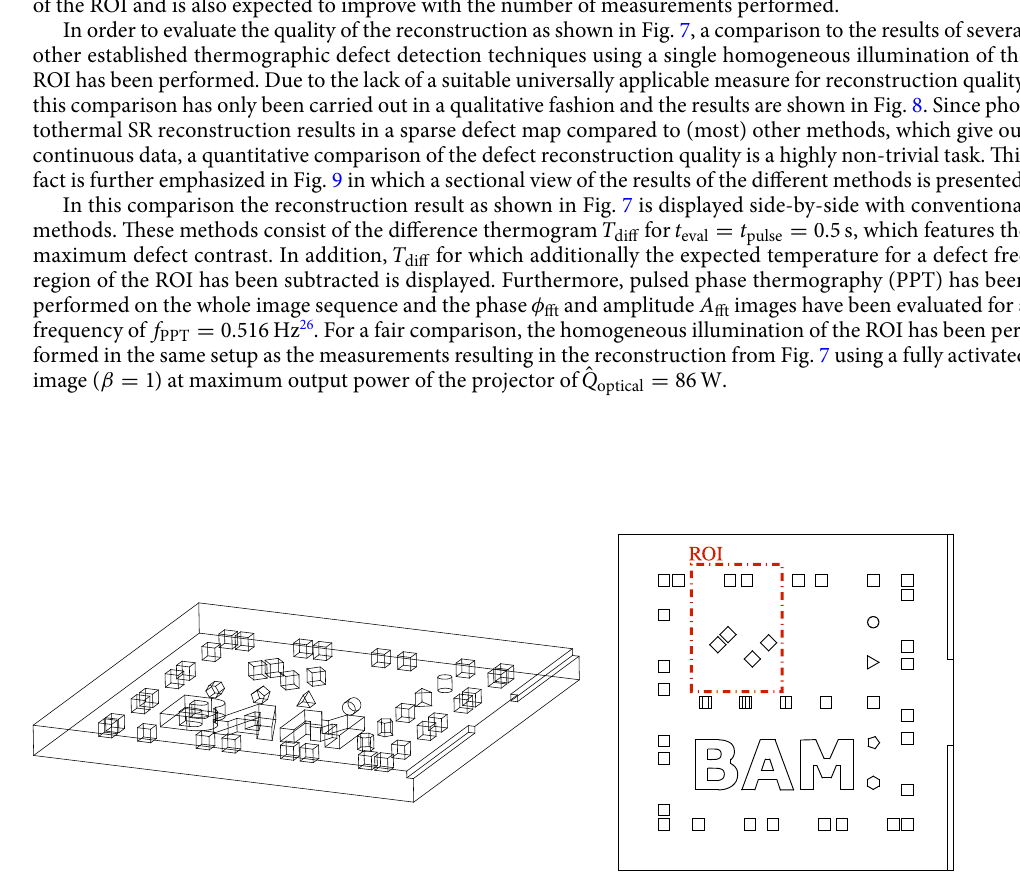
Figure 6. Object under test and ROI: The OuT investigated within this work has been additively manufactured from 316L stainless steel featuring several cubical internal defects with side lengths d defect = 2 mm of unfused metal powder lying 0.5 mm below the front surface. The ROI considered in this work encompasses three defect pairs with spacings { 0.5, 1, 2 } mm with two defect pairs oriented at 45° to the illumination pattern grid and the sensor pixel grid of the MWIR camera. Left: isometric wire frame view of the OuT, Right: front view (wire frame) with ROI.